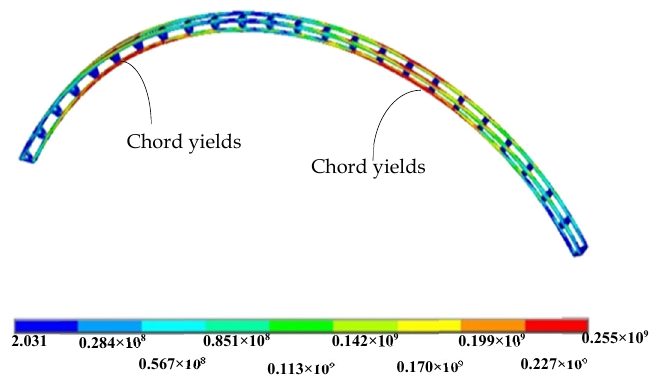
Figure 31. Global stress distribution of global failure under HSUVL (Pa).